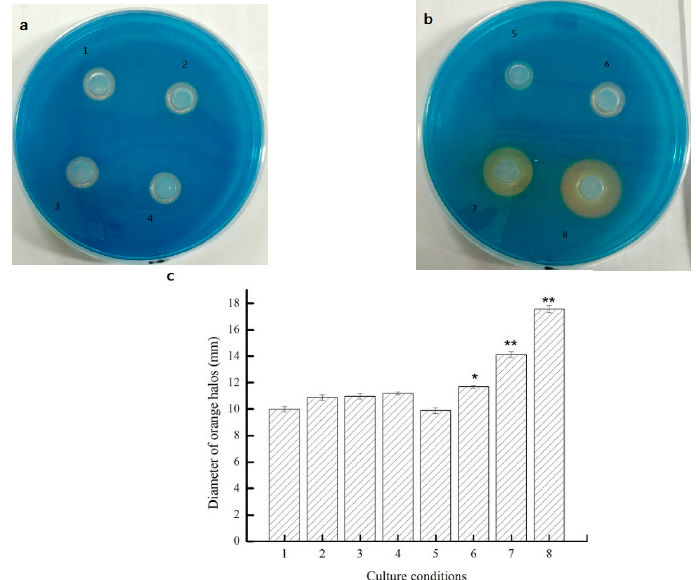
Figure 5. The effects of exogenous autoinducers on siderophore formation in AS7 ( c )—( a ): ( 2 ), 10 µ M C 6 –HSL; ( 3 ), 20 µ M C 6 –HSL; ( 4 ), 40 µ M C 6 –HSL and ( b ): ( 6 ), 10 µ M C 8 –HSL; ( 7 ), 20 µ M C 8 –HSL; ( 8 ), 40 µ M C 8 –HSL. ( 1 ) and ( 5 ) was as the control. Data were presented as the mean ˘ standard deviation ( n = 3; * p < 0.05; ** p <